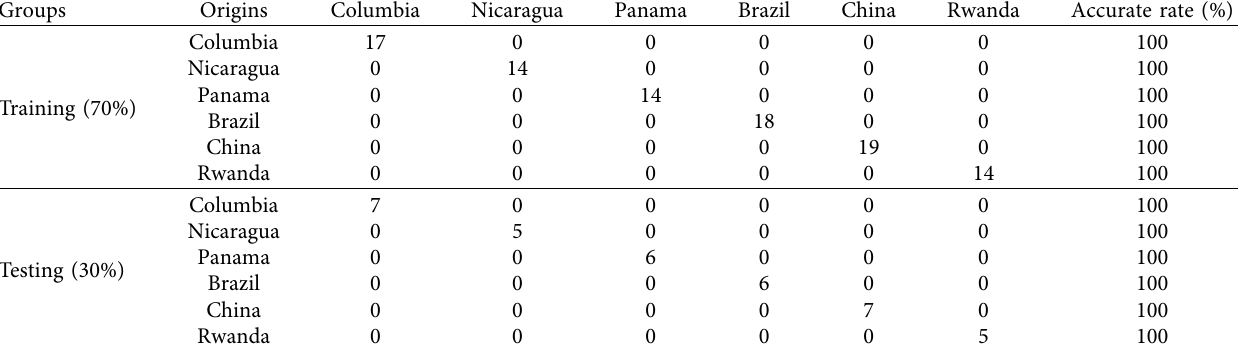
Table 5: Classifcation of 131 green beans from six diferent original regions by RF model.